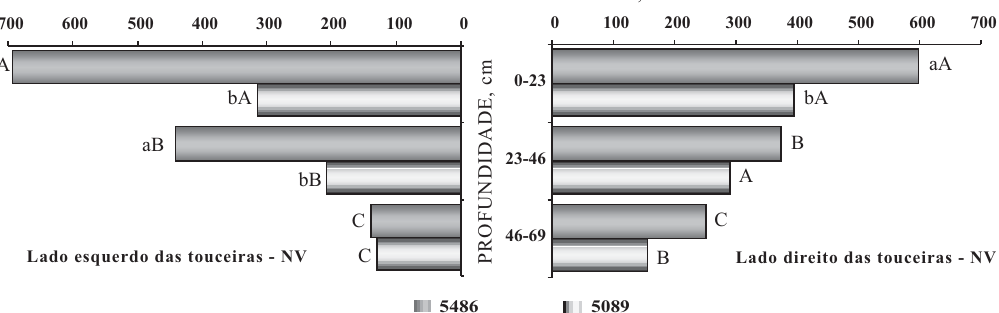
Figura 8. Comprimento radicular de soqueiras de cana-de-açúcar em profundidade no perfil do NV. Letras minúsculas comparam cultivares dentro de cada profundidade. Letras maiúsculas comparam cada cultivar em relação às três profundidades pela Diferença Mínima Significativa (DMS) a 5 %.